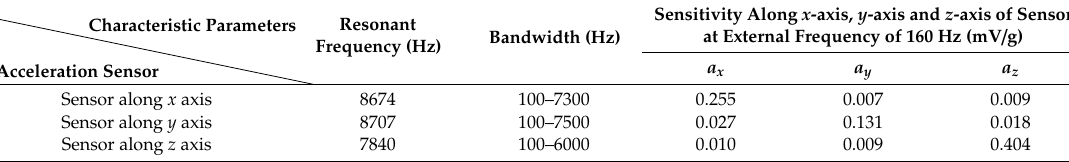
Table 1. The characteristic parameters of three-axis acceleration